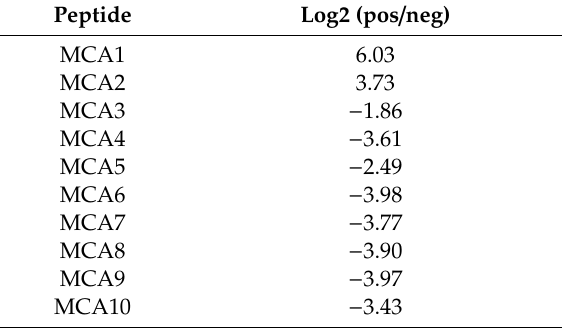
Table 1. Phage display selected clones were identified by next-generation sequencing. The fold change (Log2) was calculated for the most abundant clones. Clones with Log2 > 1.5 were selected for further